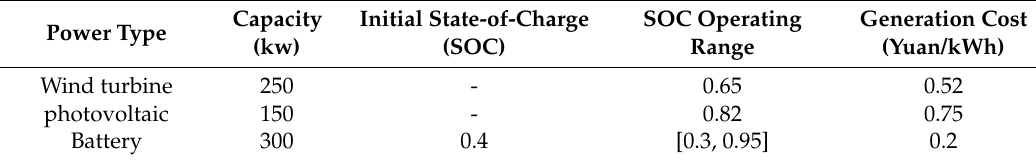
Table 1. The parameters of microgrid.